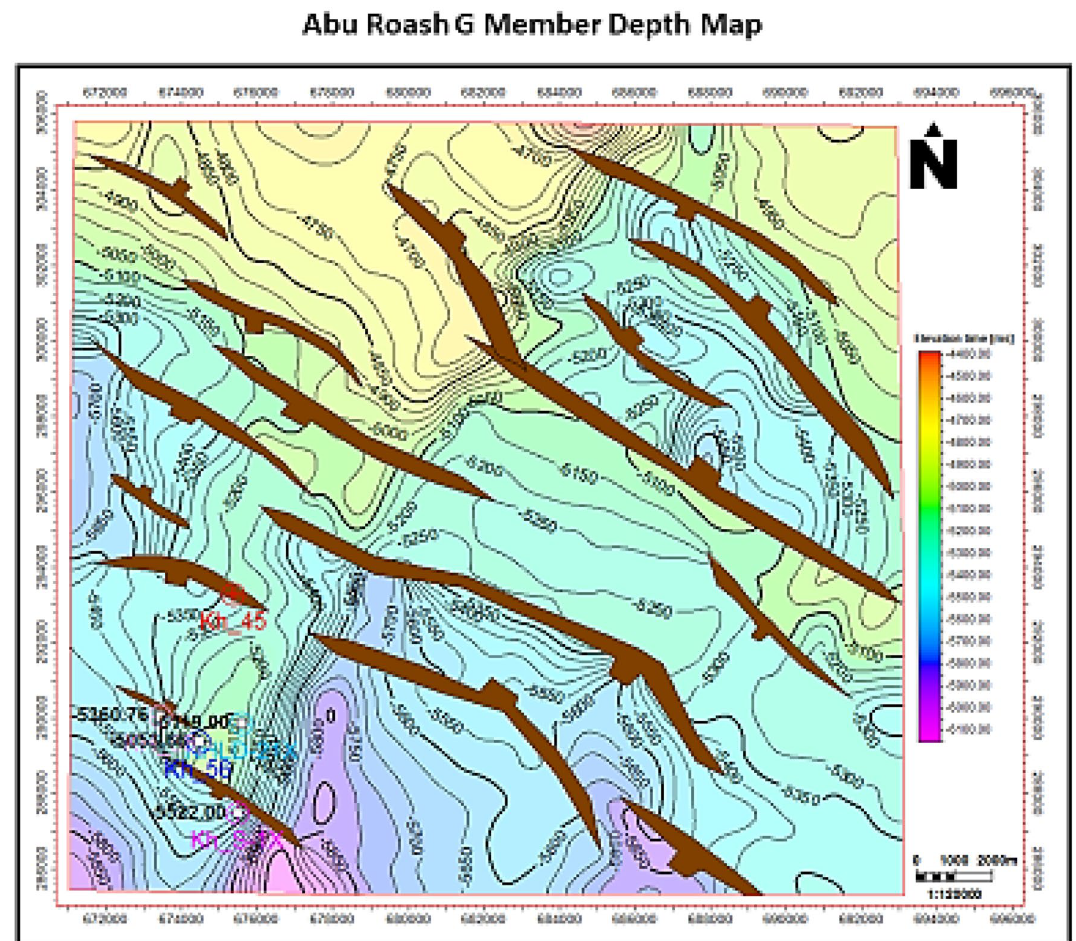
Fig. 14 The depth structural contour map on top of the Abu Roash G member (C.I = 100